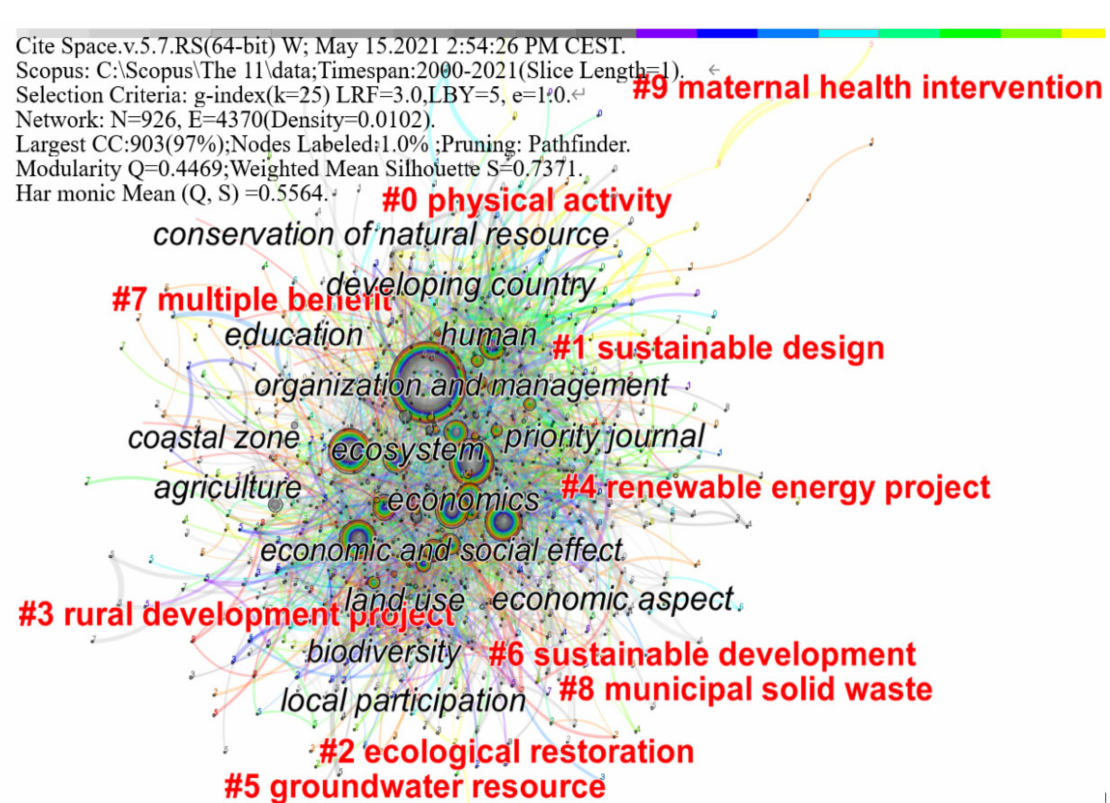
Figure 1. Keyword clustering network graph analysis of the survey literature